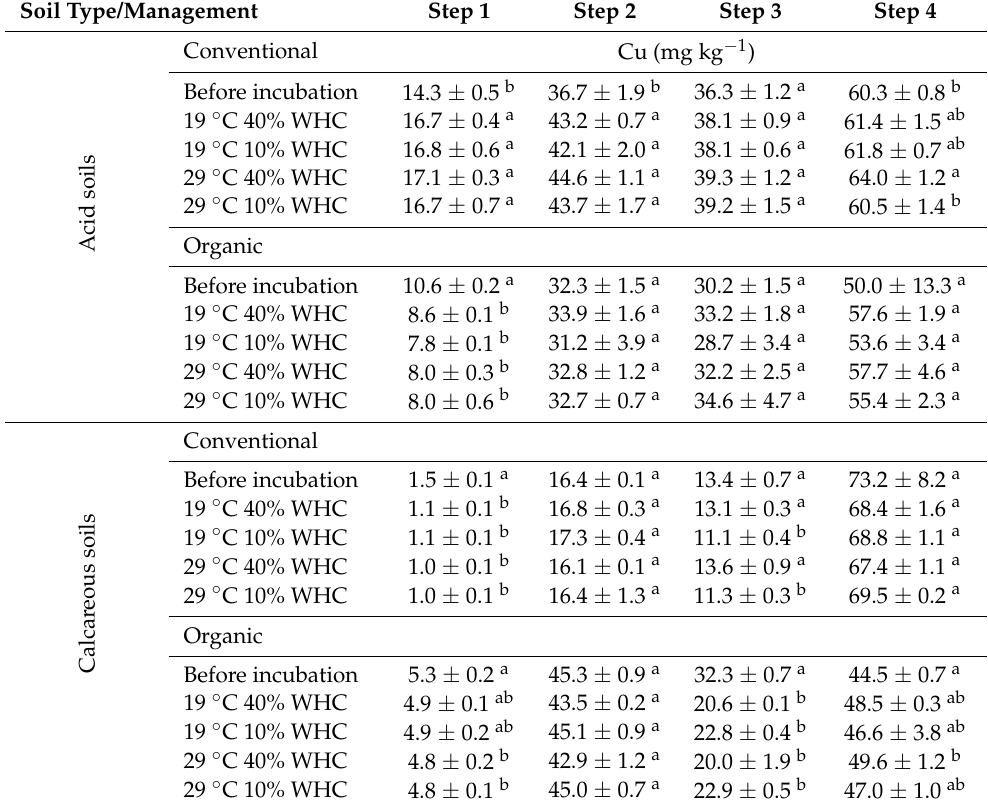
Table 2. Cu speciation in acid and calcareous soils (Cu mg kg − 1 ) with BCR four steps sequential extraction procedure before and after 6 months’ incubation under no stress (19 ◦ C and 40% WHC), moisture (19 ◦ C and 10% WHC), temperature (29 ◦ C and 40% WHC), and combined stresses (29 ◦ C and 10%